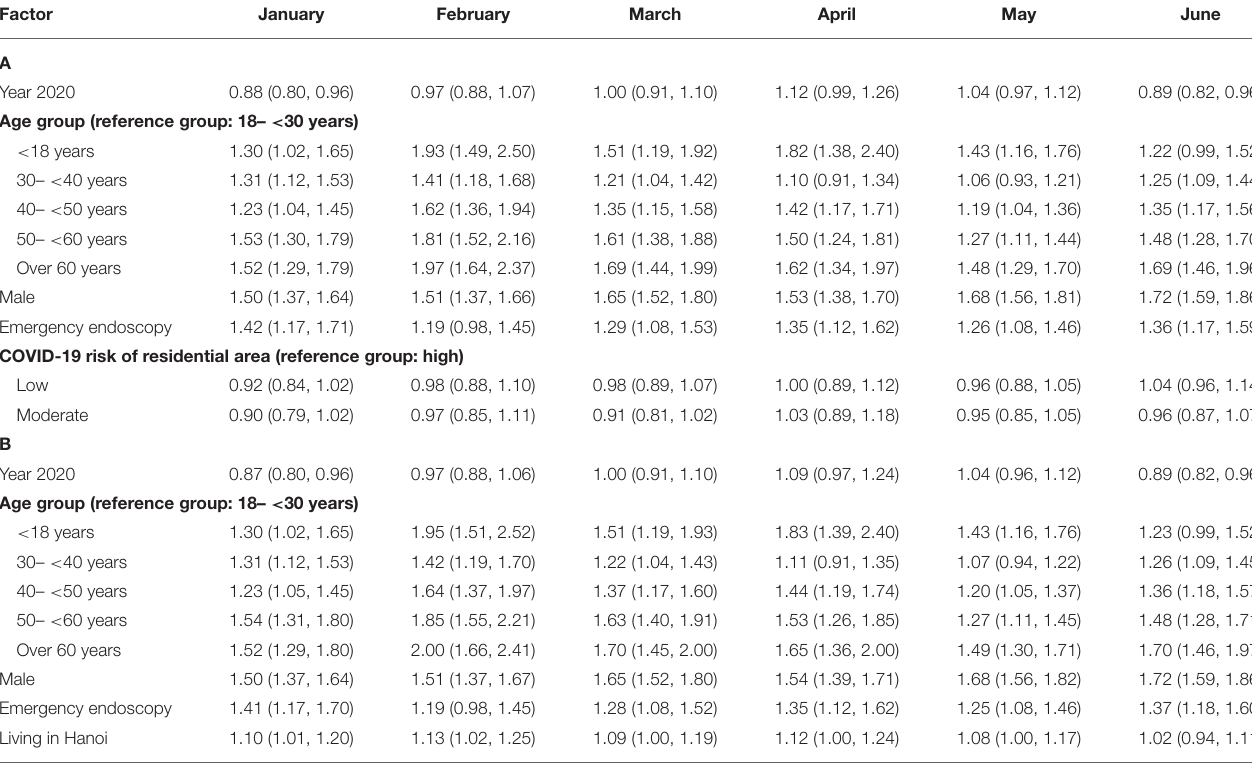
TABLE 3 | The log-binomial models for the proportion of PUD.